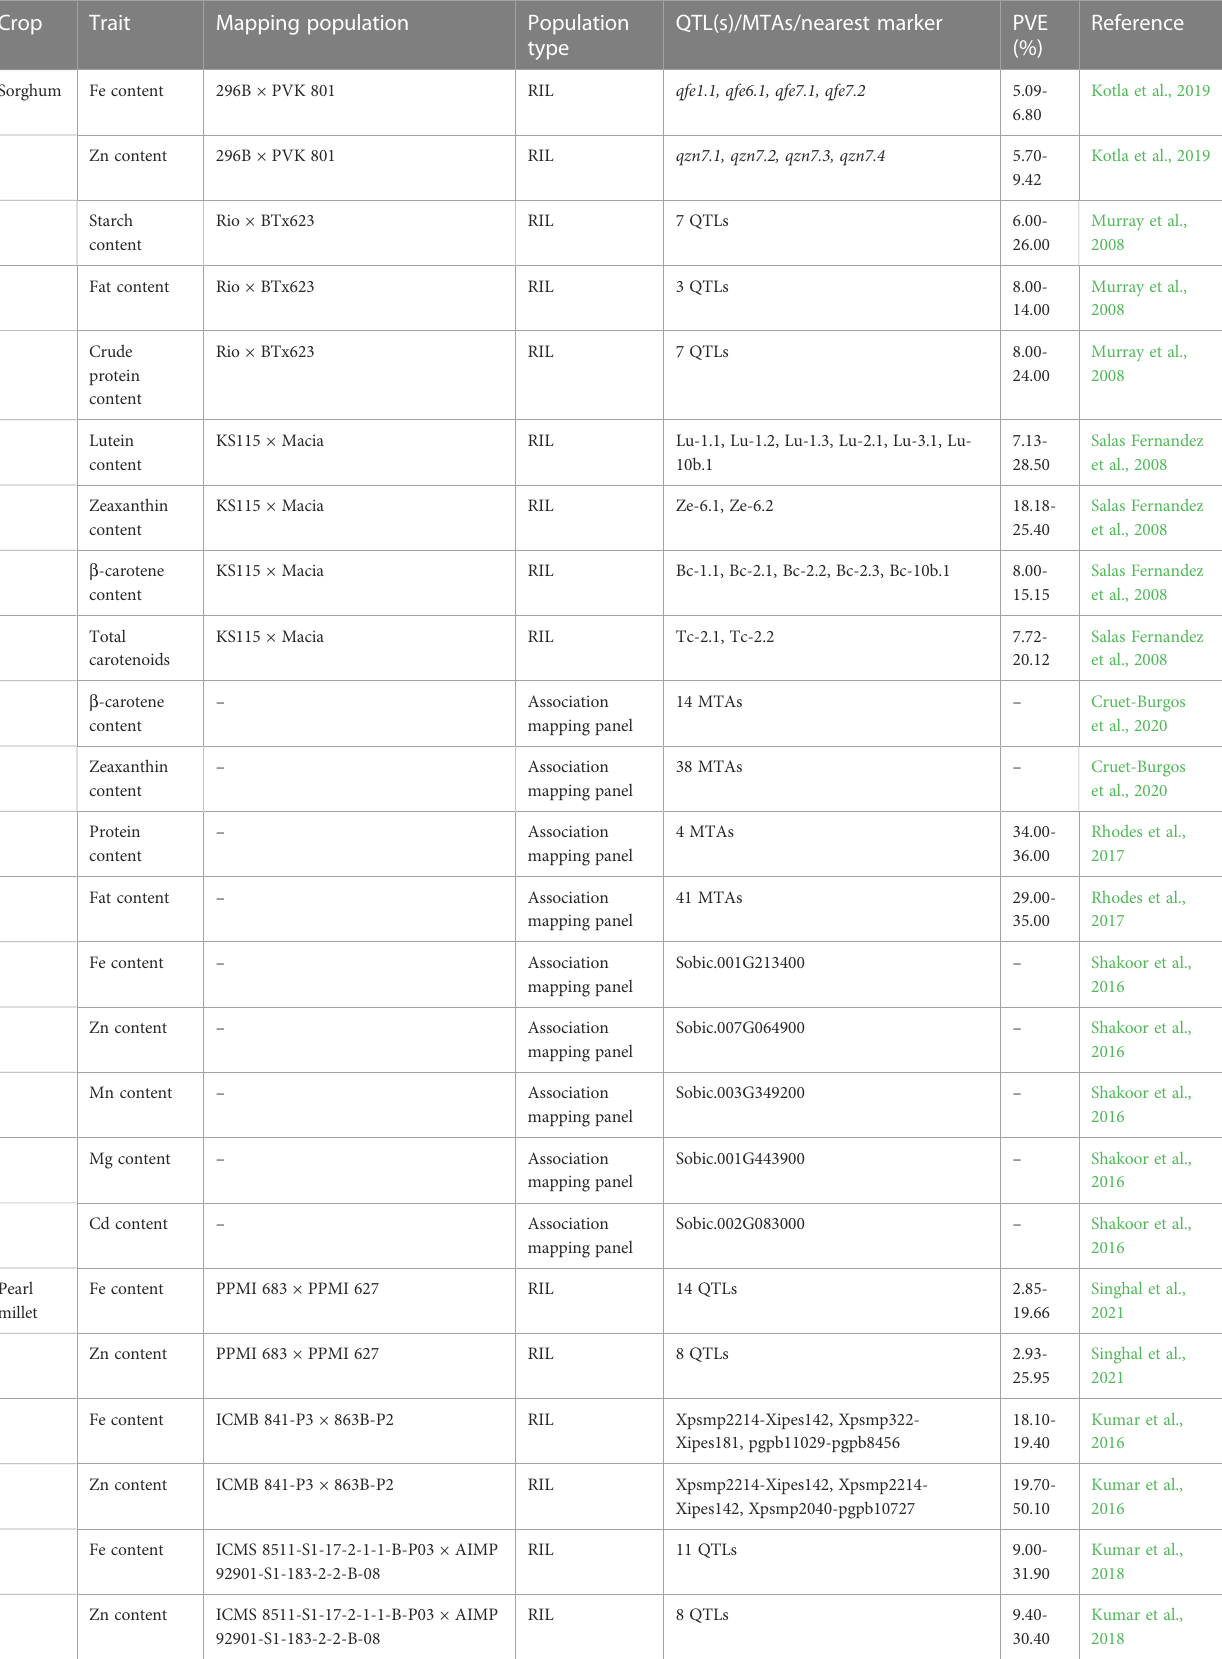
TABLE 2 A list of some key QTLs identi fi ed for grain nutrient content in